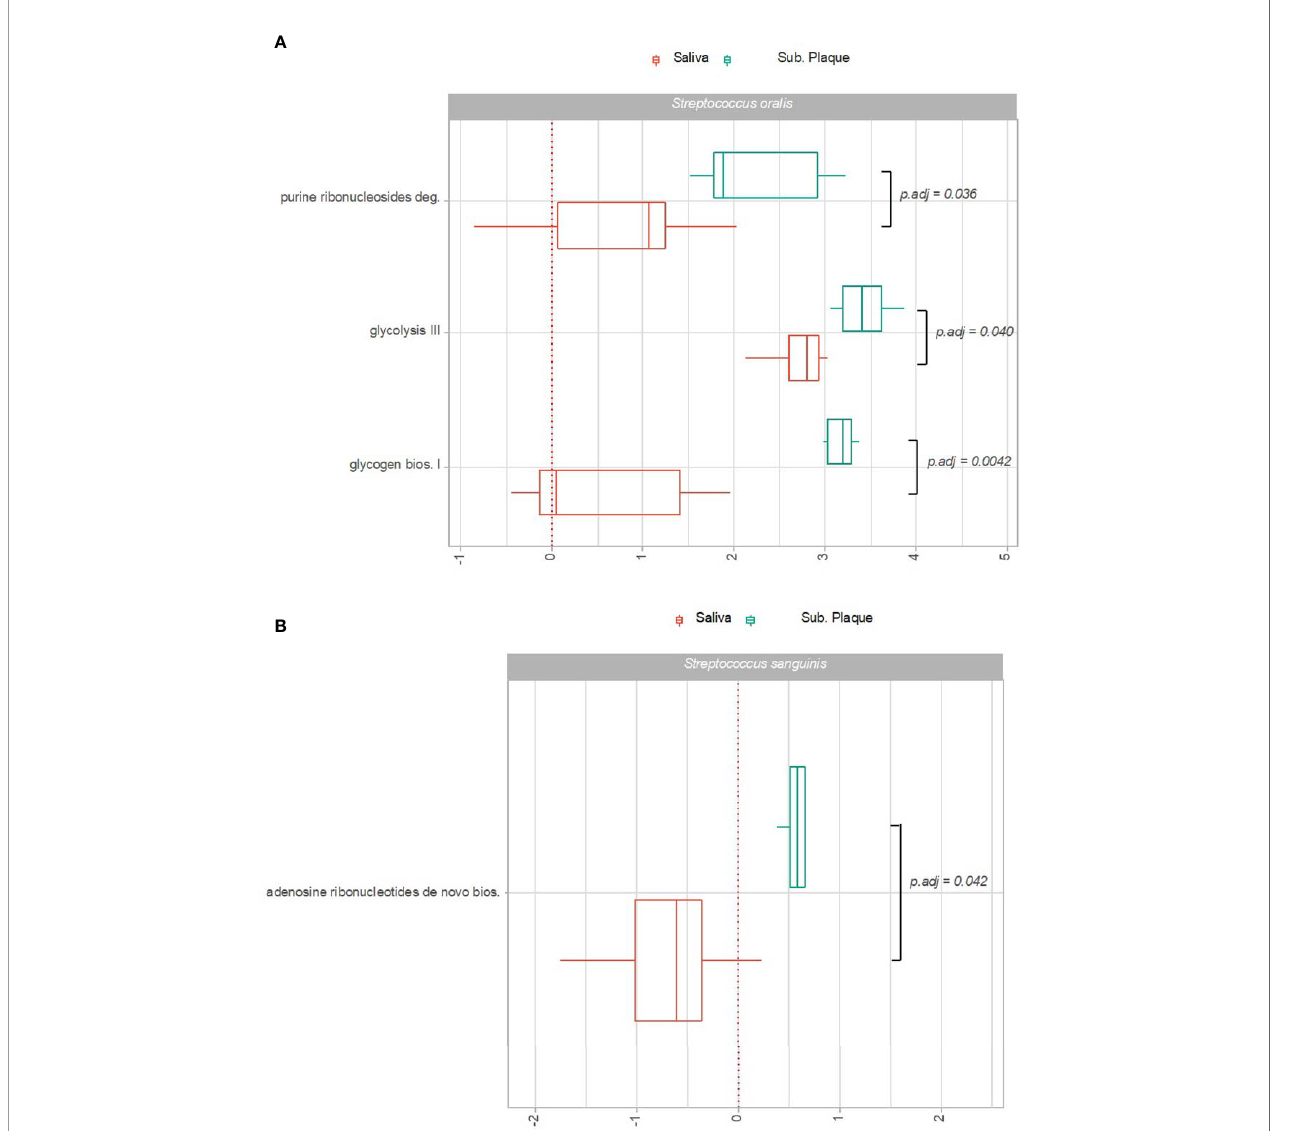
FIGURE 4 | Pathway expression of predominant Streptococcus species in saliva versus subgingival plaque. Pathways identi fi ed with signi fi cantly different log2(RNA/ DNA) in saliva versus subgingival plaque in oral health with each dot representing a speci fi c sample. (A) Streptococcus oralis , (B) Streptococcus sanguinis . Boxplots display fi rst and third quartiles, median. Whiskers display 1.5 * IQR. Color coding: red: saliva, green: subgingival